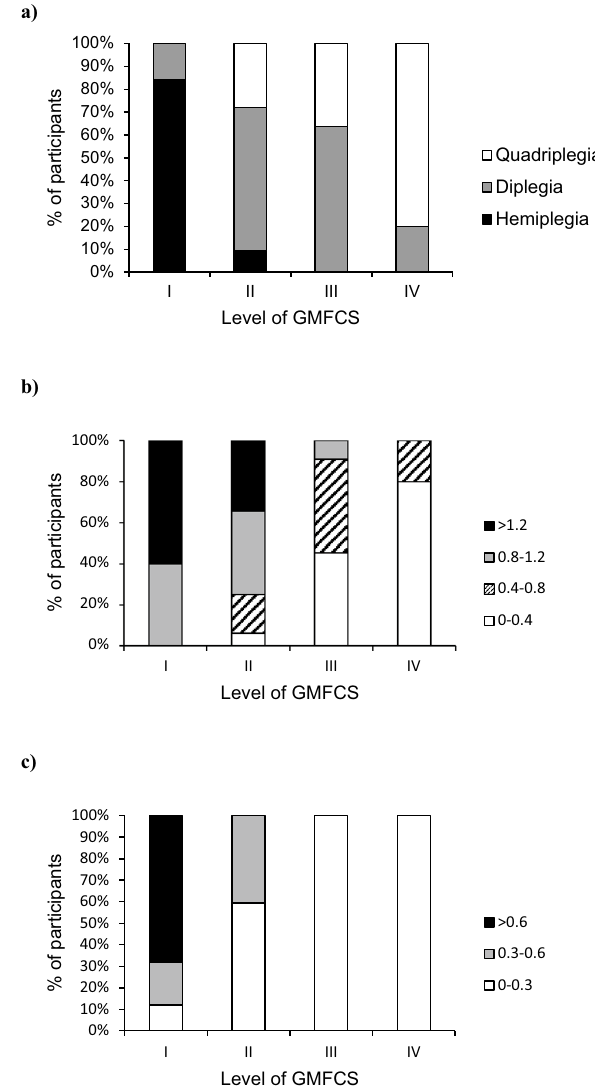
Figure 1. Distribution of ( a ) types of cerebral palsy, ( b ) walking speed (m/s) and ( c ) coordination (taps/s) across levels of Gross Motor Function Classification System (GMFCS).